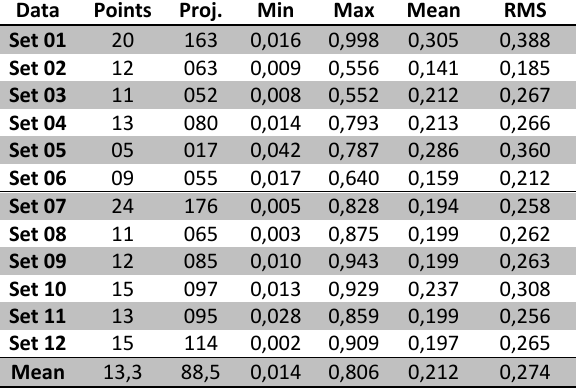
Table 1. Reprojection error in pixels for 1062 target measurements in 12 independent datasets. The targets were automatically measured and subsequently triangulated. Columns: point count, number of projections, minimum reprojection error, maximum, mean and RMS.